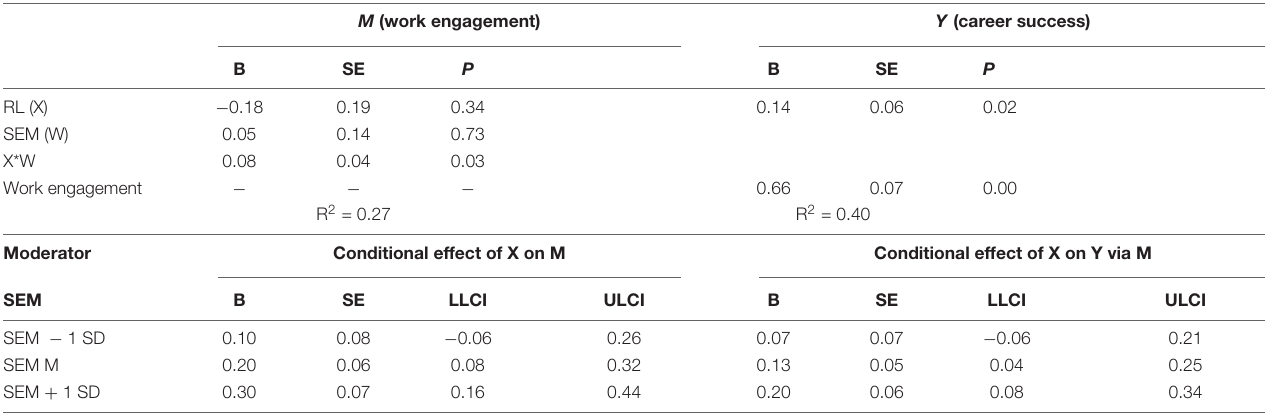
N = 228. B = standardized coefficient, SE = standard error, LLCI = lower limit of confidence interval, ULCI = upper limit of confidence